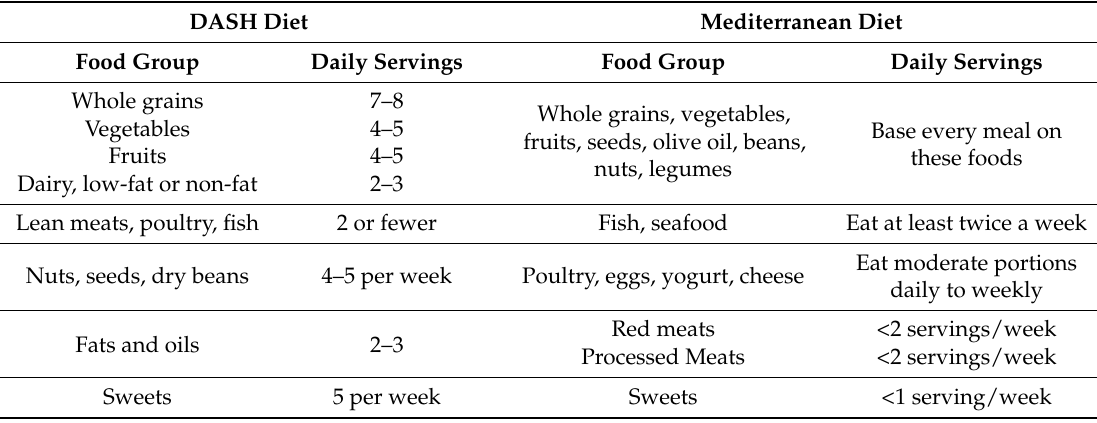
Table 1. Food group distribution in DASH and Mediterranean